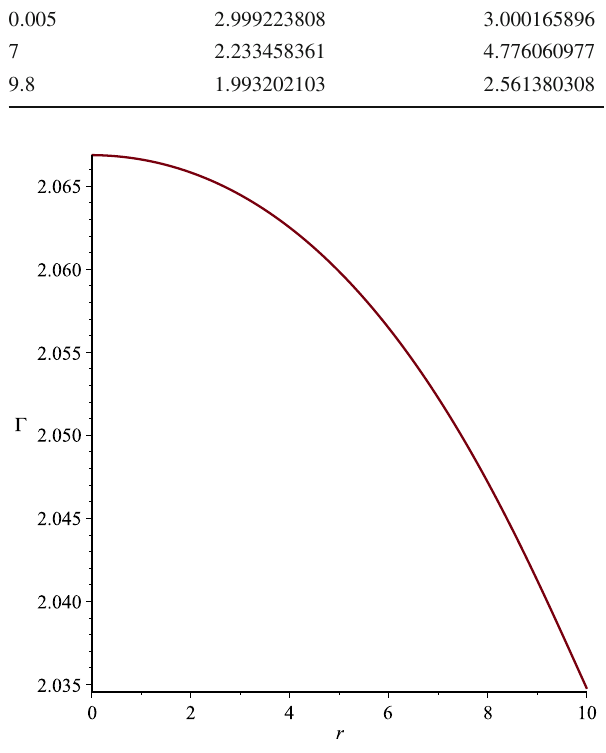
Fig. 7 Adiabatic index versus r without DM